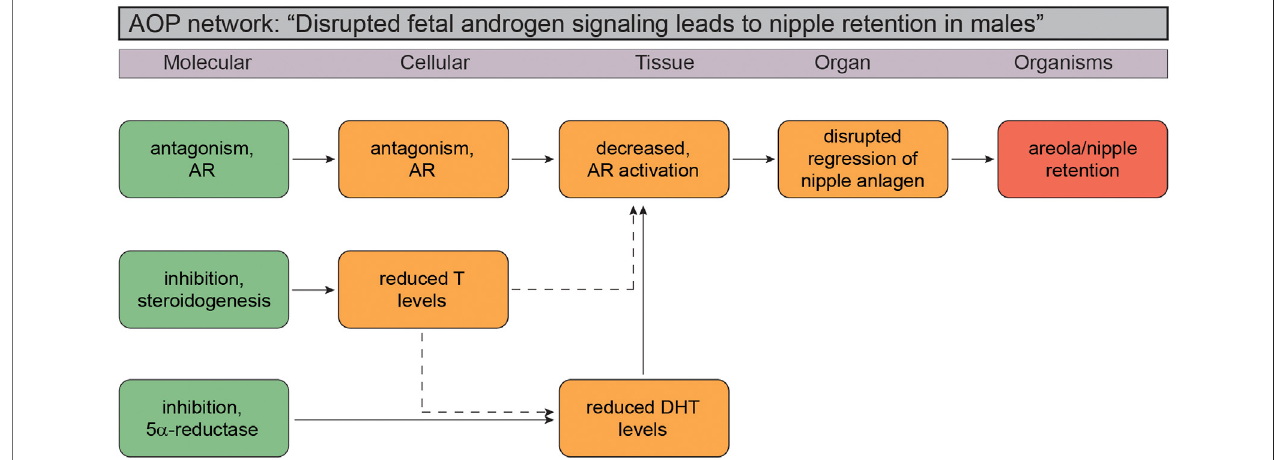
FIGURE2| PutativeAdverseOutcomePathway(AOP)networkfordisruptedandrogensignalingleadingtonippleretentioninmalerodentoffspring.ThesmallAOP network suggest the molecular initiating event (MIE) can be any of the three vital stages of the androgen signaling axis: testosterone biosynthesis ( “ inhibition, steroidogenesis ” ), failure to convert testosterone to dihydrotestosterone (DHT; “ inhibition, 5 α -reductase ” ), or direct antagonism of the androgen receptor (AR; “ antagonism, AR ” ). Any key event that will decrease AR activation and action ultimately “ disrupts regression of the nipple anlagen ” in male rat offspring, leading to “ areola/nipple retention.